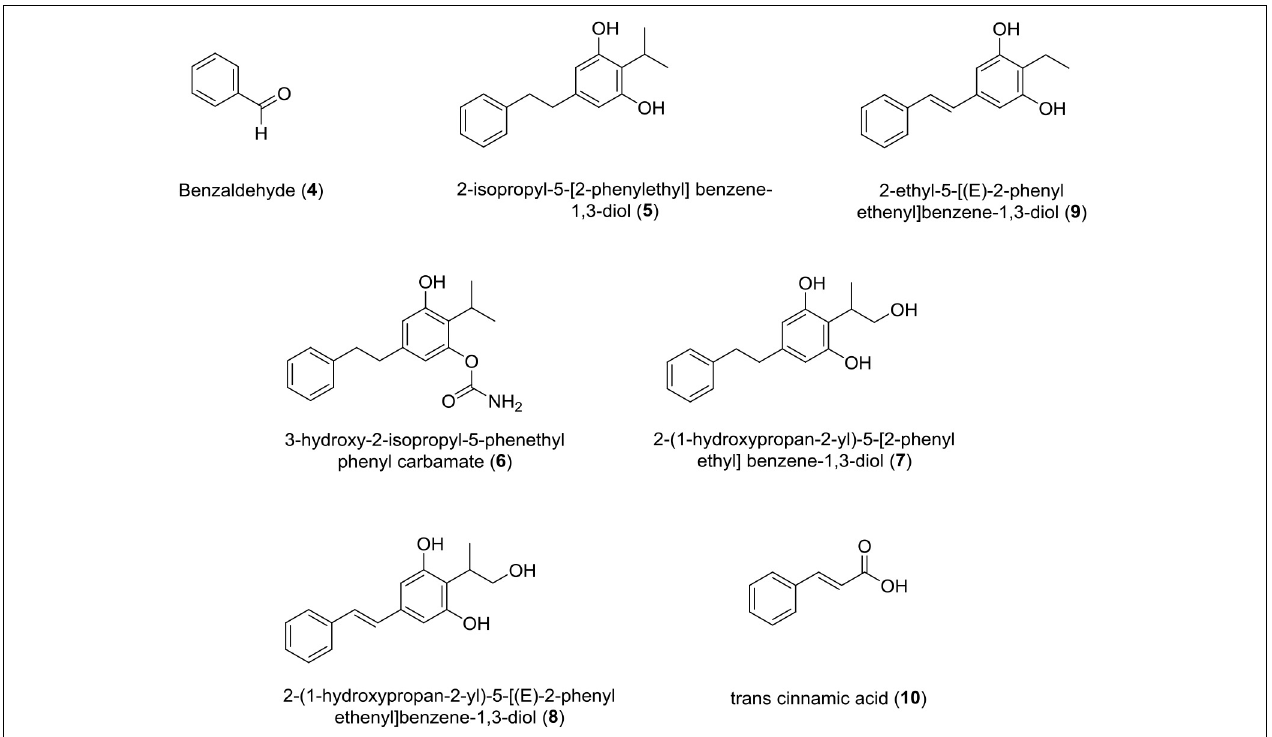
FIGURE 4 | Chemical structure of antifungal compounds (4–10)